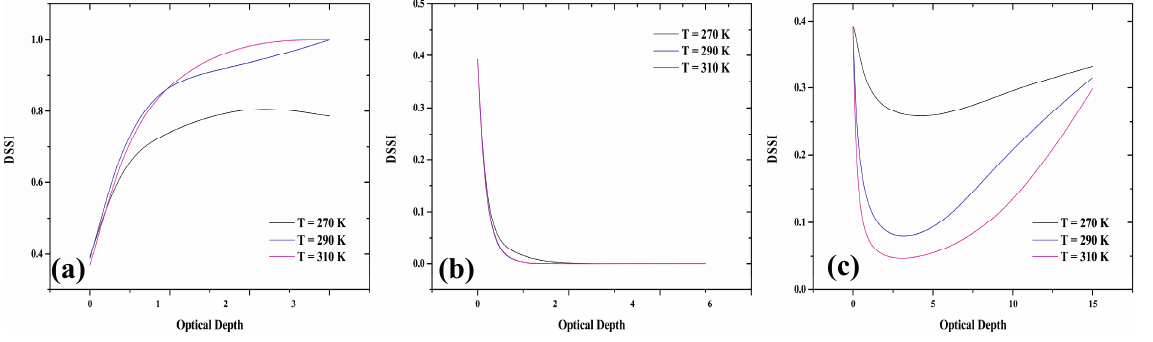
Figure 8. The effect of underlying surface temperature—T on DSSI under the conditions of ( a ) dust ( b ) ice cloud ( c ) water cloud.